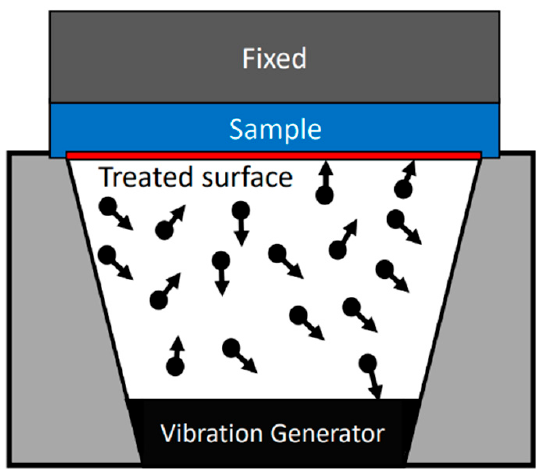
Figure 2. Schematic highlighting the most important features of the SMAT system.